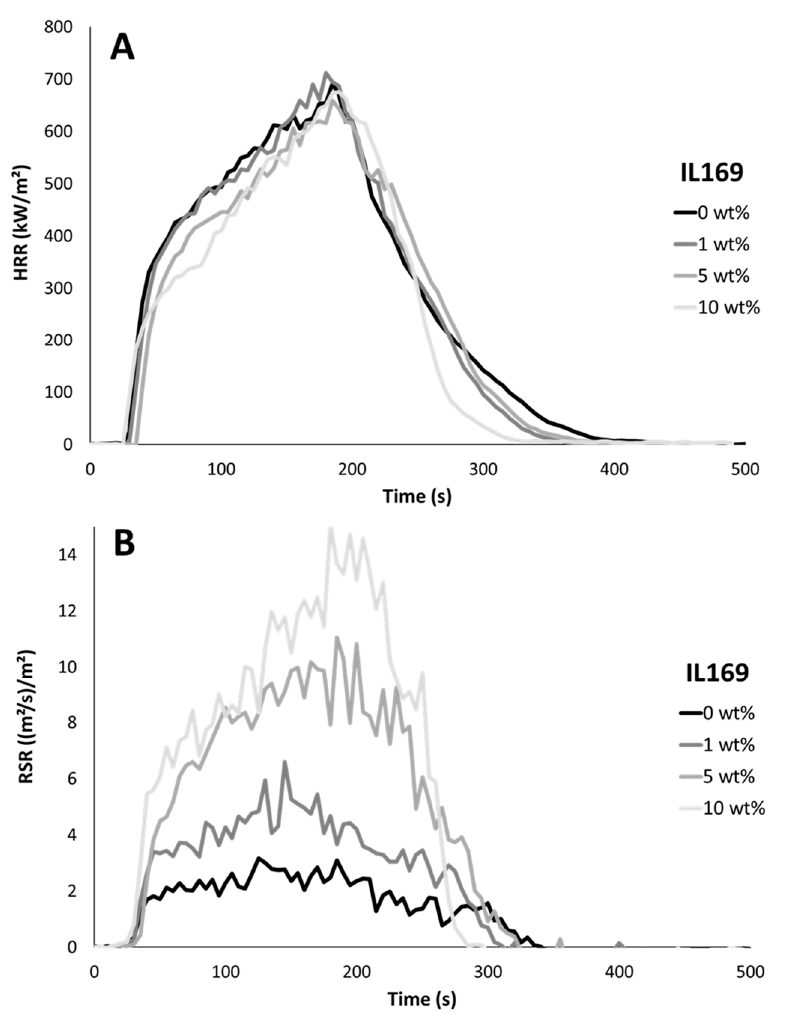
Figure 2. ( A )/HRR versus time in cone calorimeter (50 kW/m 2 ) for Elium resin filled with various contents of IL169. ( B )/RSR versus time in cone calorimeter (50 kW/m 2 ) for Elium resin filled